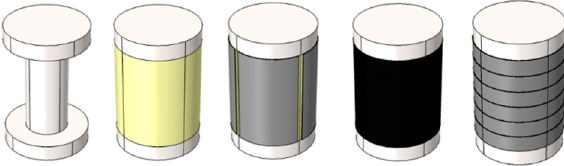
Figure 2. Decomposition of model components showing separate domains, including the 3-D-printed supporter ( white ), PDMS ( yellow ), electrodes ( gray ), and PVDF ( black ) domains.